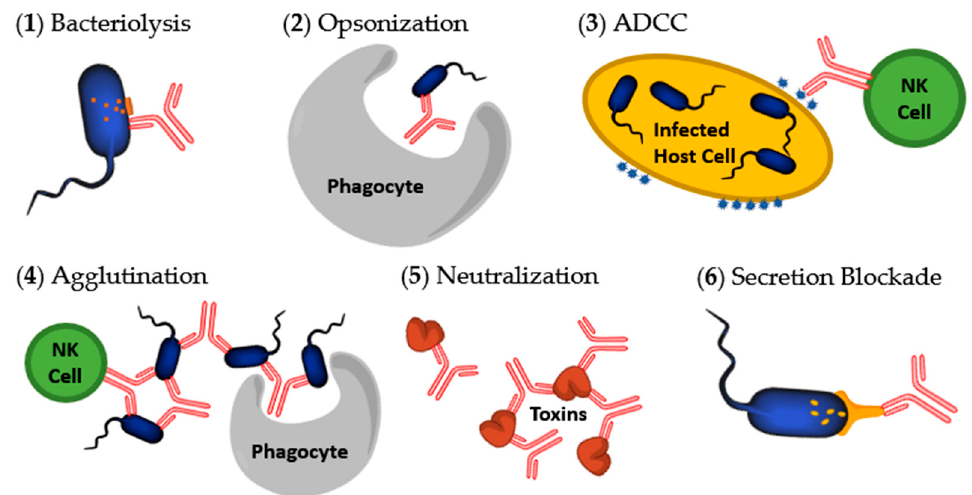
Figure 3. Mechanisms initiated by antibodies to destroy bacteria or toxins. ( 1 ) Bacteriolysis occurring after complement activation; ( 2 ) Opsonization by a macrophage or neutrophil after Fc sequence recognition; ( 3 ) Antibody ‐ dependent cell ‐ mediated cytotoxicity (ADCC) of an infected host cell; ( 4 ) Agglutination; ( 5 ) Neutralization of a bacterial secreted toxin; ( 6 ) Secretion blockade preventing T3SS proteins from being secreted. Image modified from [34].